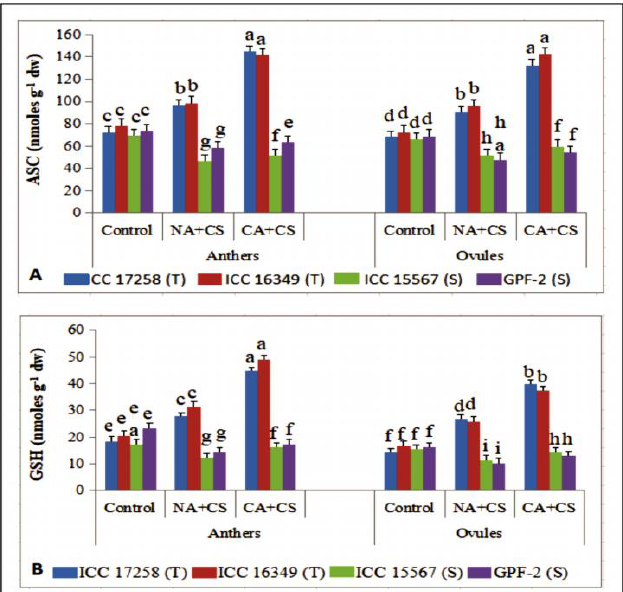
Figure 8. Ascorbate (ASC; ( A )) and reduced glutathione (GSH; ( B )) in anthers and ovules of control, non-acclimated, cold stressed; NA + CS) and cold-acclimated, cold stressed (CA + CS) plants of tolerant (T) and sensitive (S) genotypes. Small vertical bars represent standard errors (Mean ± S. E; n = 3). Different small letters on vertical bars indicate significant differences from each other ( p < 0.05; Tukey’s test). Least significant difference (LSD) for interaction ( p < 0.05) (Genotypes × treatments): ASC (6.9), GSH